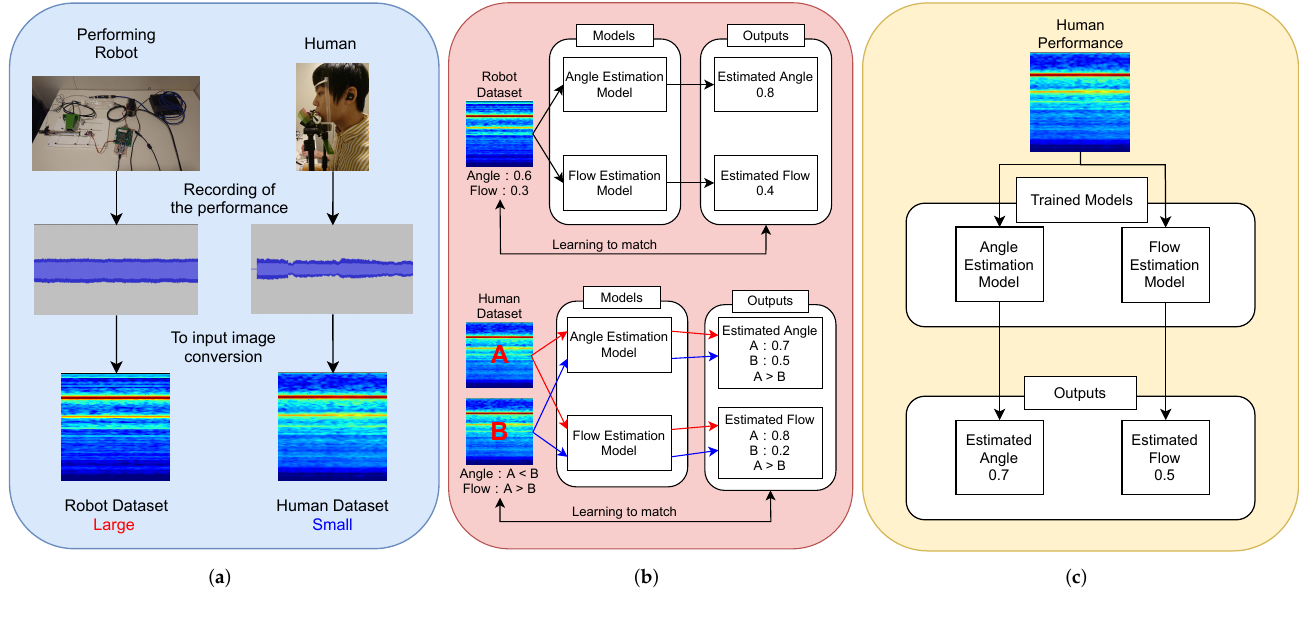
Figure 2. System diagram of the control parameter estimation system. Data were created from a flute playing robot and human performance. We used the dataset to train a model for control parameter estimation, which was separated for each estimated parameter. The trained models were used to estimate the parameters of human performance. Thus, it is possible to obtain control parameters only from the performance recordings. ( a ) Dataset Creation. ( b ) Model Training. ( c ) Parameter